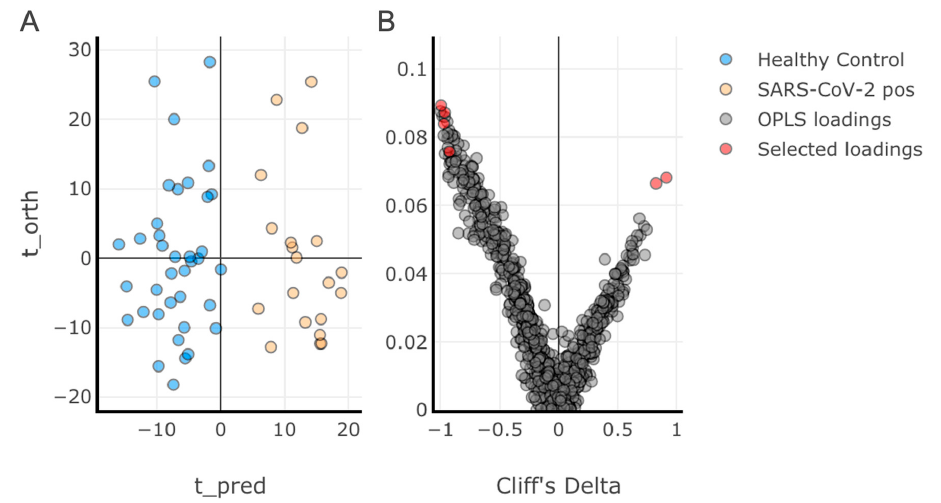
Figure 2. Orthogonal projection to latent structures discriminant analysis (OPLS-DA) on the discovery training dataset. ( A ) Scores plot representing the two groups (healthy controls and SARS-CoV-2-positive); ( B ) Loadings plot presented in the form of an eruption plot (Cliff’s delta vs. OPLS loadings). A discriminant model was achieved (R 2 = 0.26, AUC = 0.99). The lipids that made up the final classifier are highlighted in panel B. To select candidates for the final lipid classifier panel, lipids were filtered by the fol- lowing criteria: Cliff’s delta estimates > 0.7; did not correlate with an existing member of the panel across the total dataset (Pearson’s > 0.8) (Supplementary Table S1); and only one individual lipid per class was considered. From this, a classification panel of six lipids